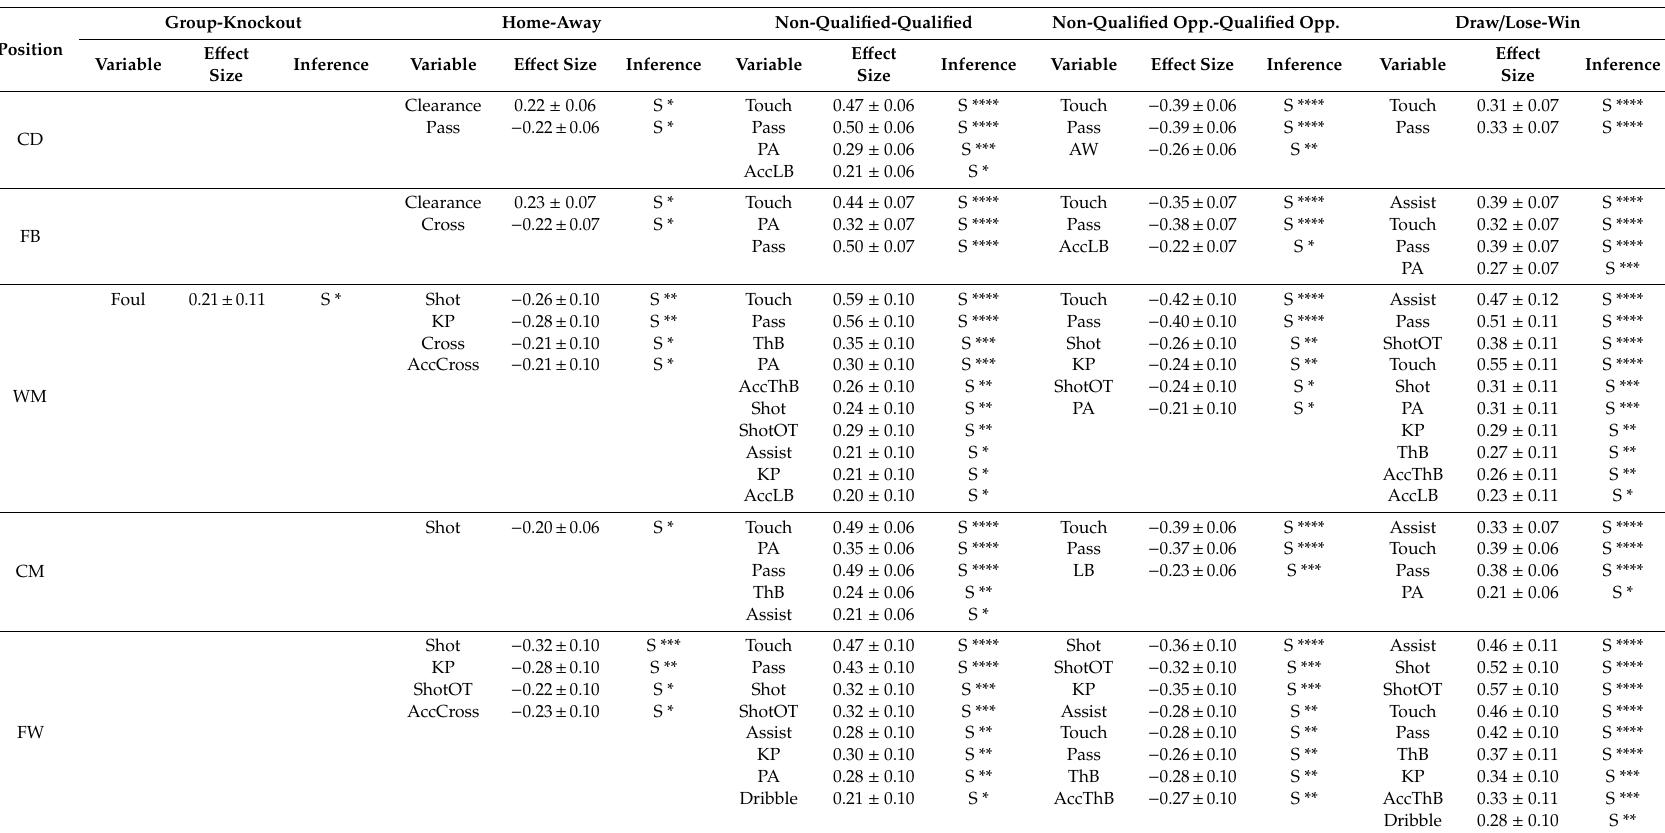
Table 2. Statistical di ff erences of players’ match performance across five playing positions and five competing